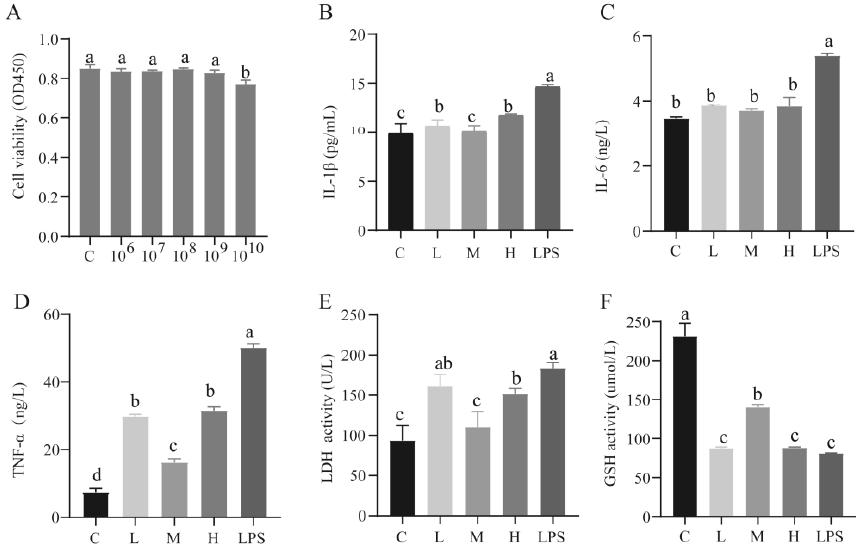
Figure 1. Effects of the pretreatment of different concentration of L. rhamnosus CY12 on cell viabil- ity, cytokines expression, LDH and GSH activity in LPS-induced Caco-2 Cells. ( A ). Cell viability. ( B ). IL-1 β level. ( C ) IL-6 level. ( D ). TNF- α level. ( E ). LDH activity. ( F ). GSH activity. Note: C represents uninduced Caco-2 cells; L, M, and H represent LPS-induced Caco-2 cells co-incubated with 10 7 , 10 8 and 10 9 cfu/mL L. rhamnosus CY12, respectively; LPS represents LPS-induced Caco-2 cells. Data were presented as mean ± SEM. Means with the different letters are significantly different p <